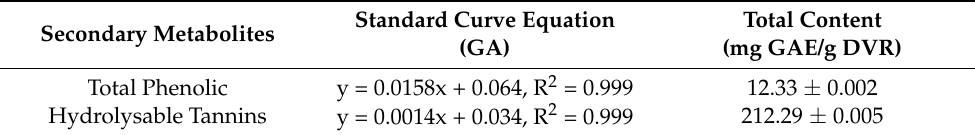
Table 6. D. villosa root-quantitative determination of total phenols, and hydrolyzable tannins. Secondary